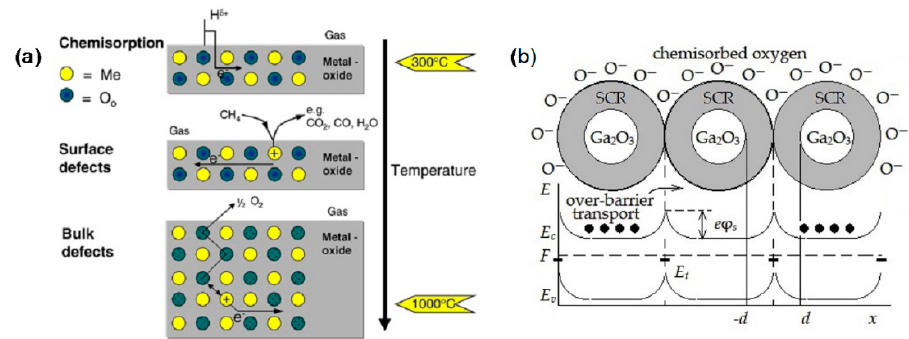
Figure 8. ( a ) The model of the three temperature-dependent regimes of the gas reaction of Ga 2 O 3 [182]. Copyright 2008 IOP. ( b ) The model and corresponding energy diagram of Ga 2 O 3 grain contact